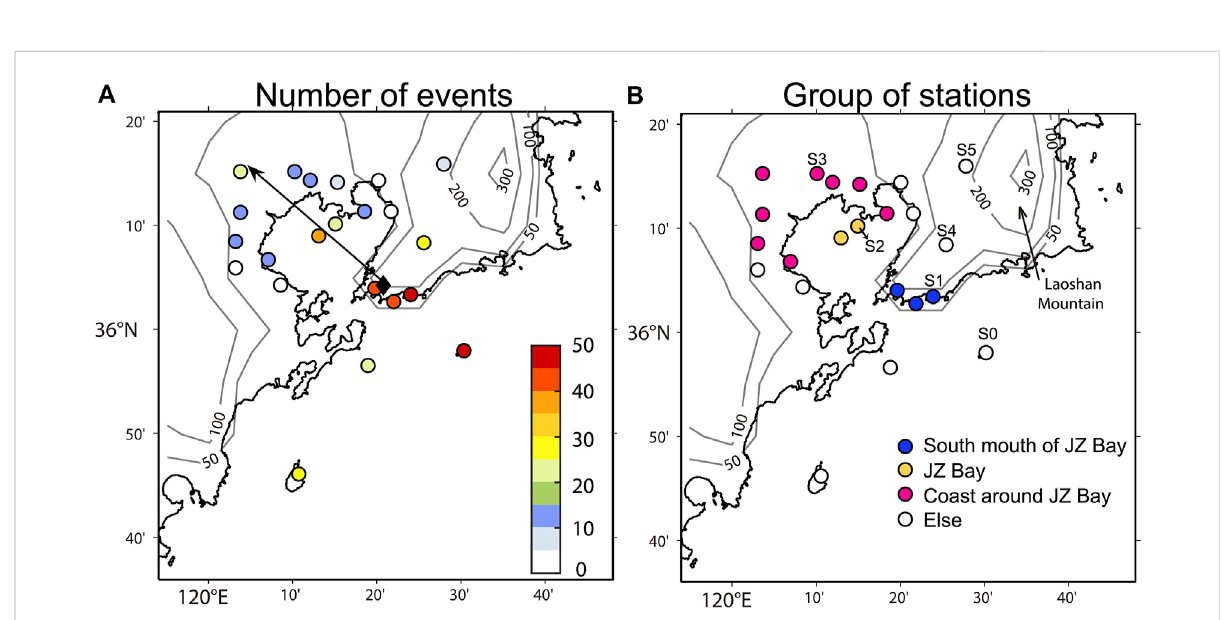
FIGURE 4 NumbersofSFPeventsateveryAWS (A) andgroupsofAWSsbasedonlocations (B) .Thegraycontoursindicatetopography(m).In (A) ,thearrow expresses the median direction of the SFP events (shown in Figure 2 ’ s inset). The black diamond expresses the average location where SFP starts. In (B) , the names and groups of stations are given. S1, S2, and S3 are the typical stations for the three groups. S0 is a station on an island. S4 and S5 are located on Laoshan